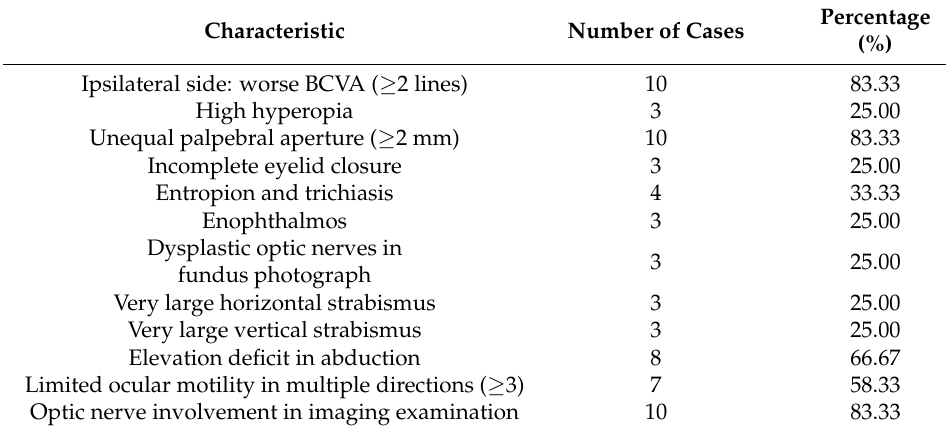
Table 2. Incidence of signs and symptoms.